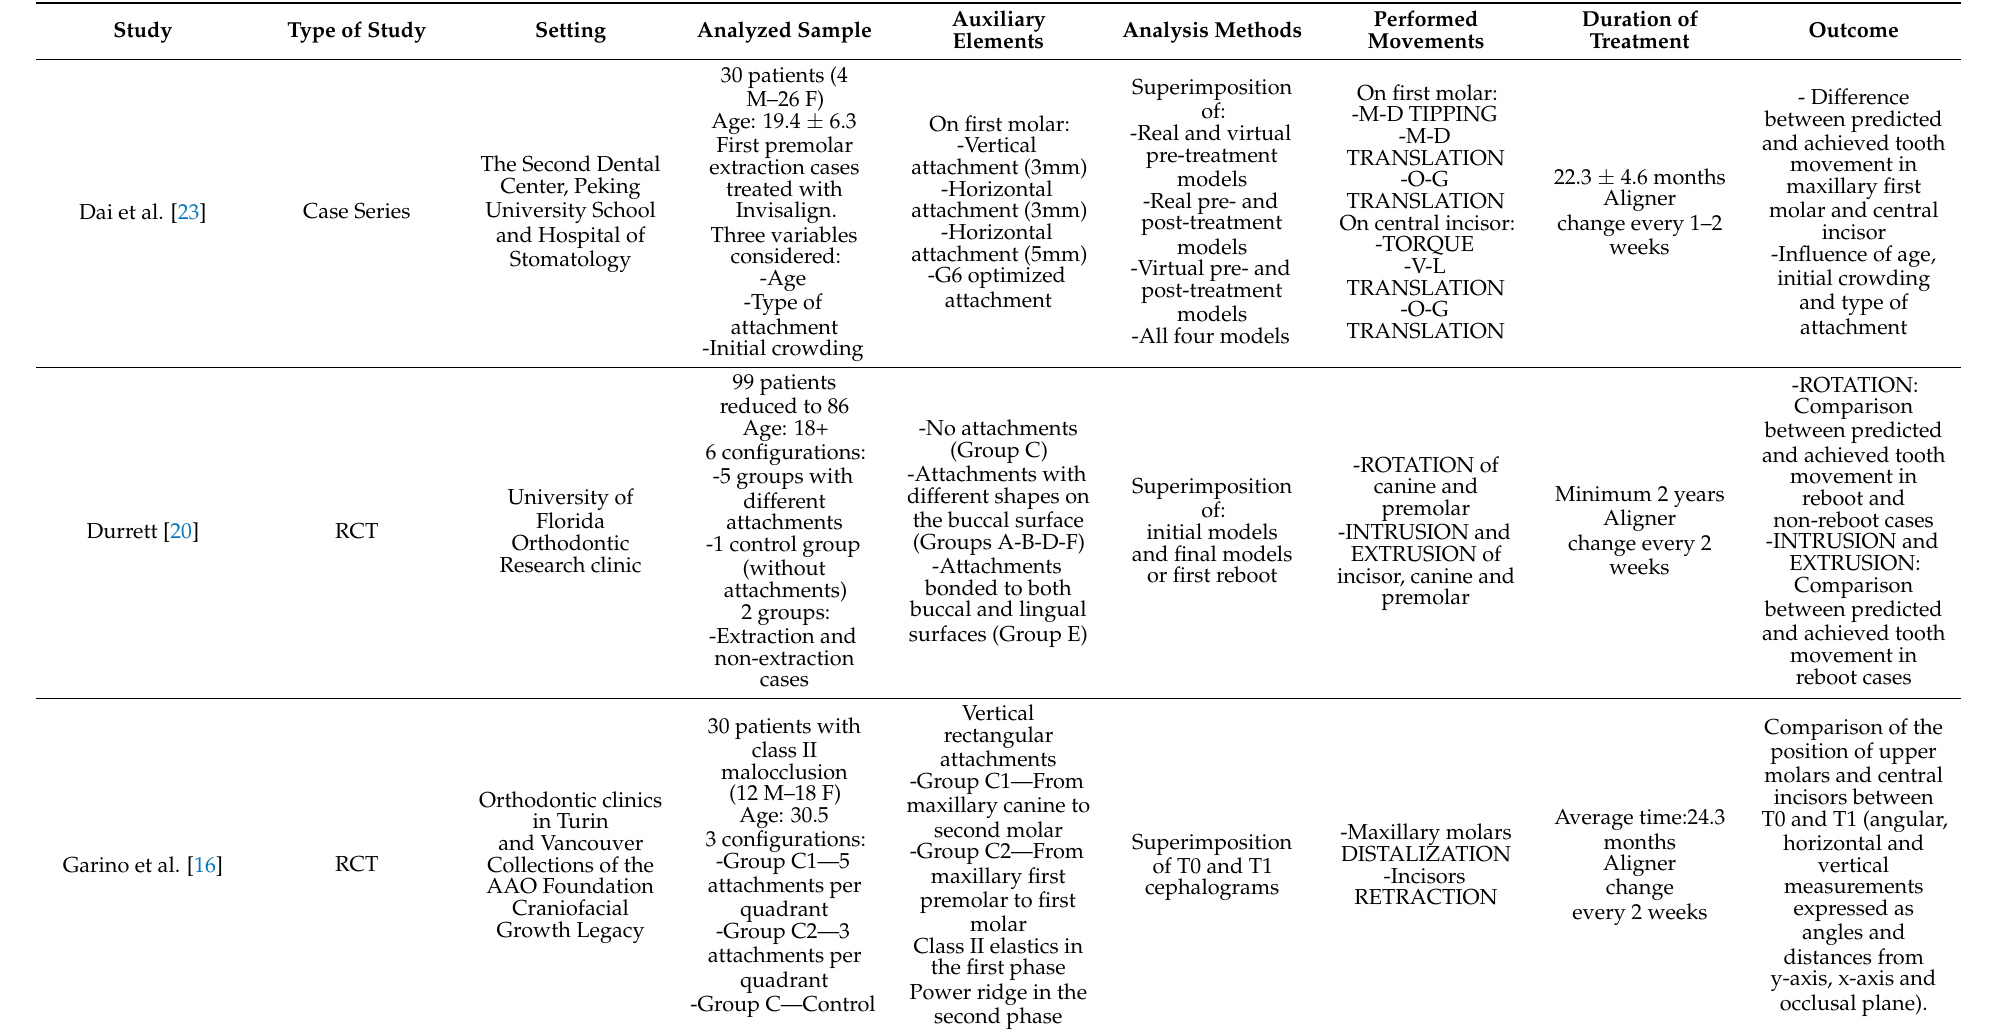
Table 2. Characteristics of included clinical